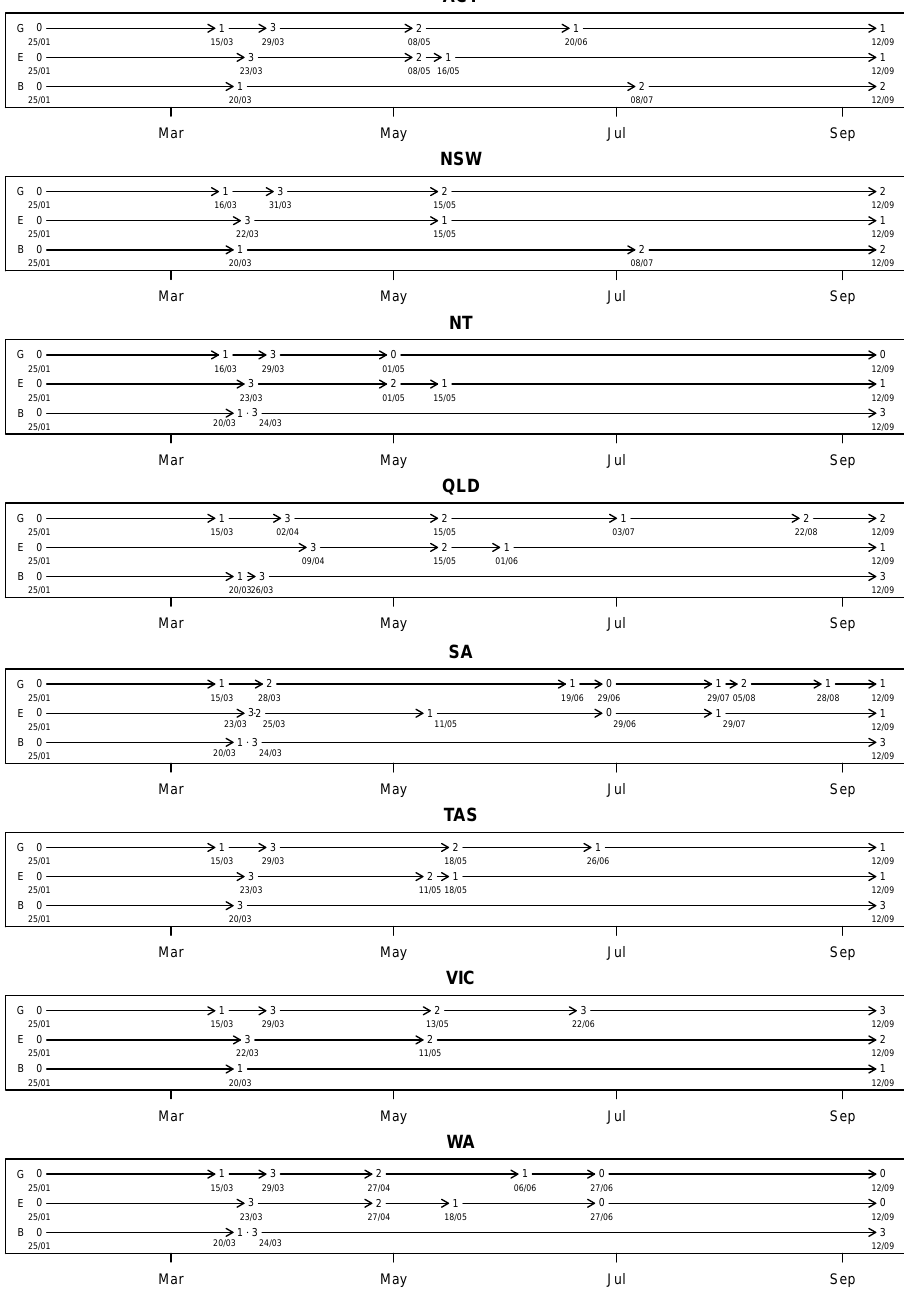
Figure 2. Dates and levels of the policies implemented in each of the states and